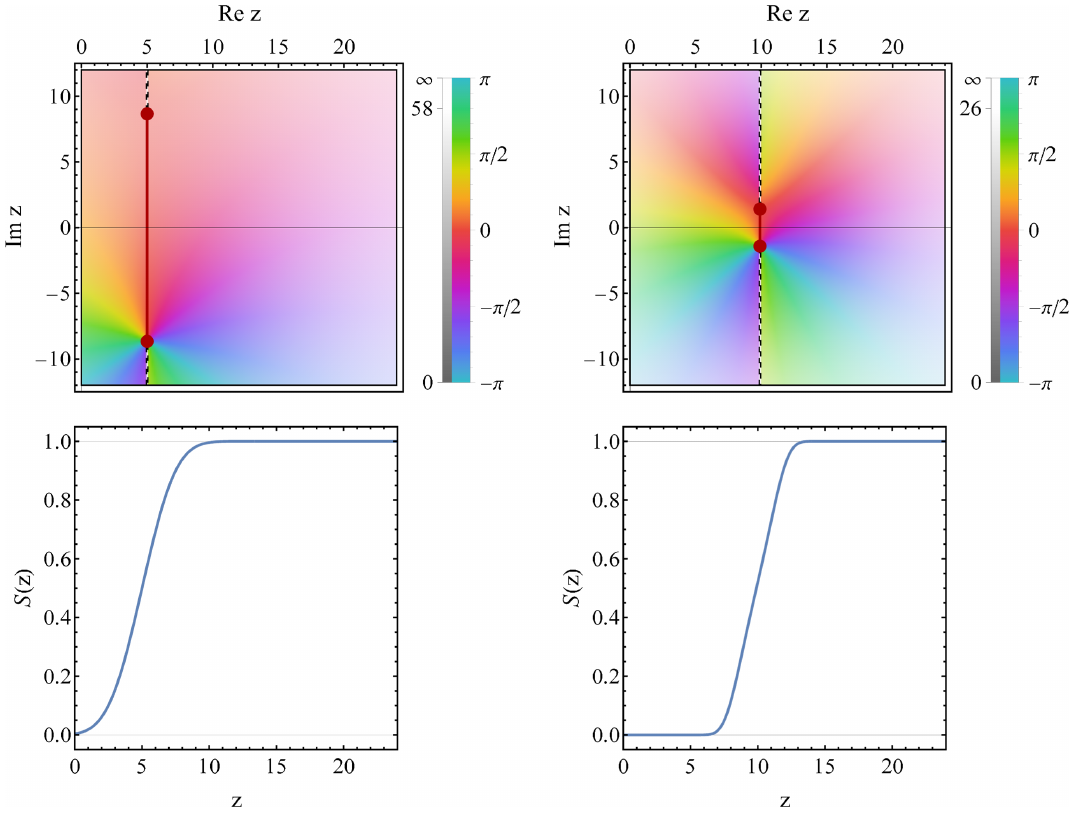
Figure 19 . The super-adiabatic singulant F ( z ) in radiation-dominated era for ˜ κ = 0 . 05 (upper left panel) and ˜ κ = 0 . 099 (upper right panel), with the dimensionless mass ˜ m = 0 . 1 . The hue represents the phase arg F ( z ) while the brightness represents the modulus | F ( z ) | . In both panels, the dark red line is the Stokes line joining the complex turning points. The lower two panels show the Stokes multiplier S ( z ) corresponding to the parameters chosen